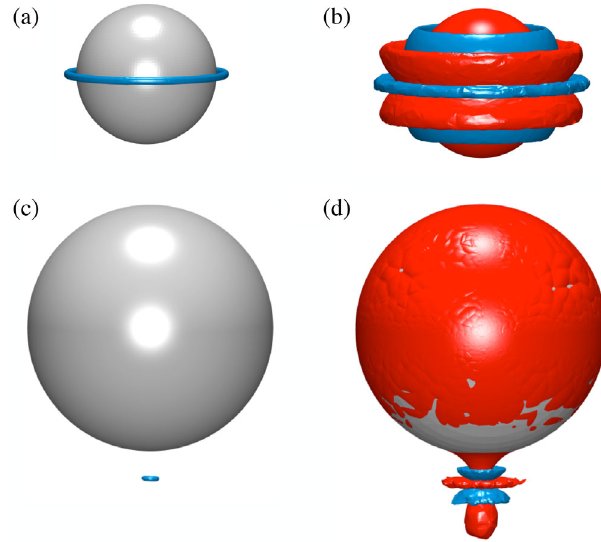
FIG. 11. Some selected isosurfaces of the net charge density ð r Þ − ρ − ð r Þ(cid:3) = ρ I s in the screening cloud around an uncharged ½ ρ þ colloidal sphere. In panels (a) and (b), we set the particle size a ¼ 250 nm such that a Saturn-ring defect is formed, while in panels (c) and (d), the particle size is a ¼ 1 μ m, creating a point defect. (a,c) Only ion partitioning, g ¼ 3 and g − ¼ 8 , and (b,d) þ G ¼ 10 pC m − 1 . The isosurface only flexoelectric coupling, q e values for ½ ρ ð r Þ − ρ − ð r Þ(cid:3) = ρ I s are (a,b) þ 0 . 25 (red) and − 0 . 25 þ (blue) and (c,d) − 0 . 15 (blue) and þ 0 . 15 (red). The colloidal particle is shown in